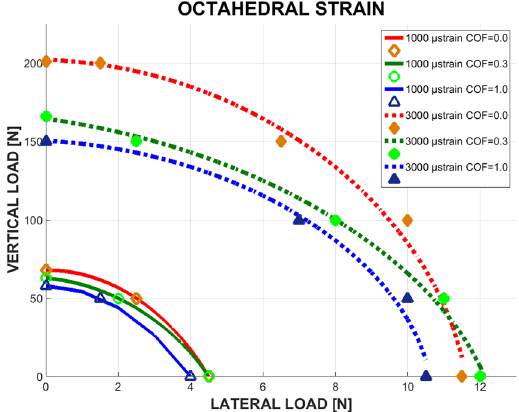
Figure 3. Graphs of lateral load vs. vertical load, causing cortical bone octahedral strain of magnitude 1000 µ ε (solid curves) and 3000 µ ε (dashed curves), for 3 levels of COF and isotropic bone